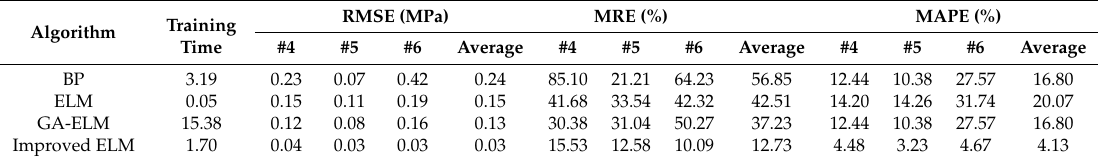
Figure 12. Comparison between output from prediction models and in-situ data of ( a ) #4 crosscut, ( b ) #5 crosscut, and ( c ) #6 crosscut. Table 2. Comparison of prediction performance obtained from different algorithms.